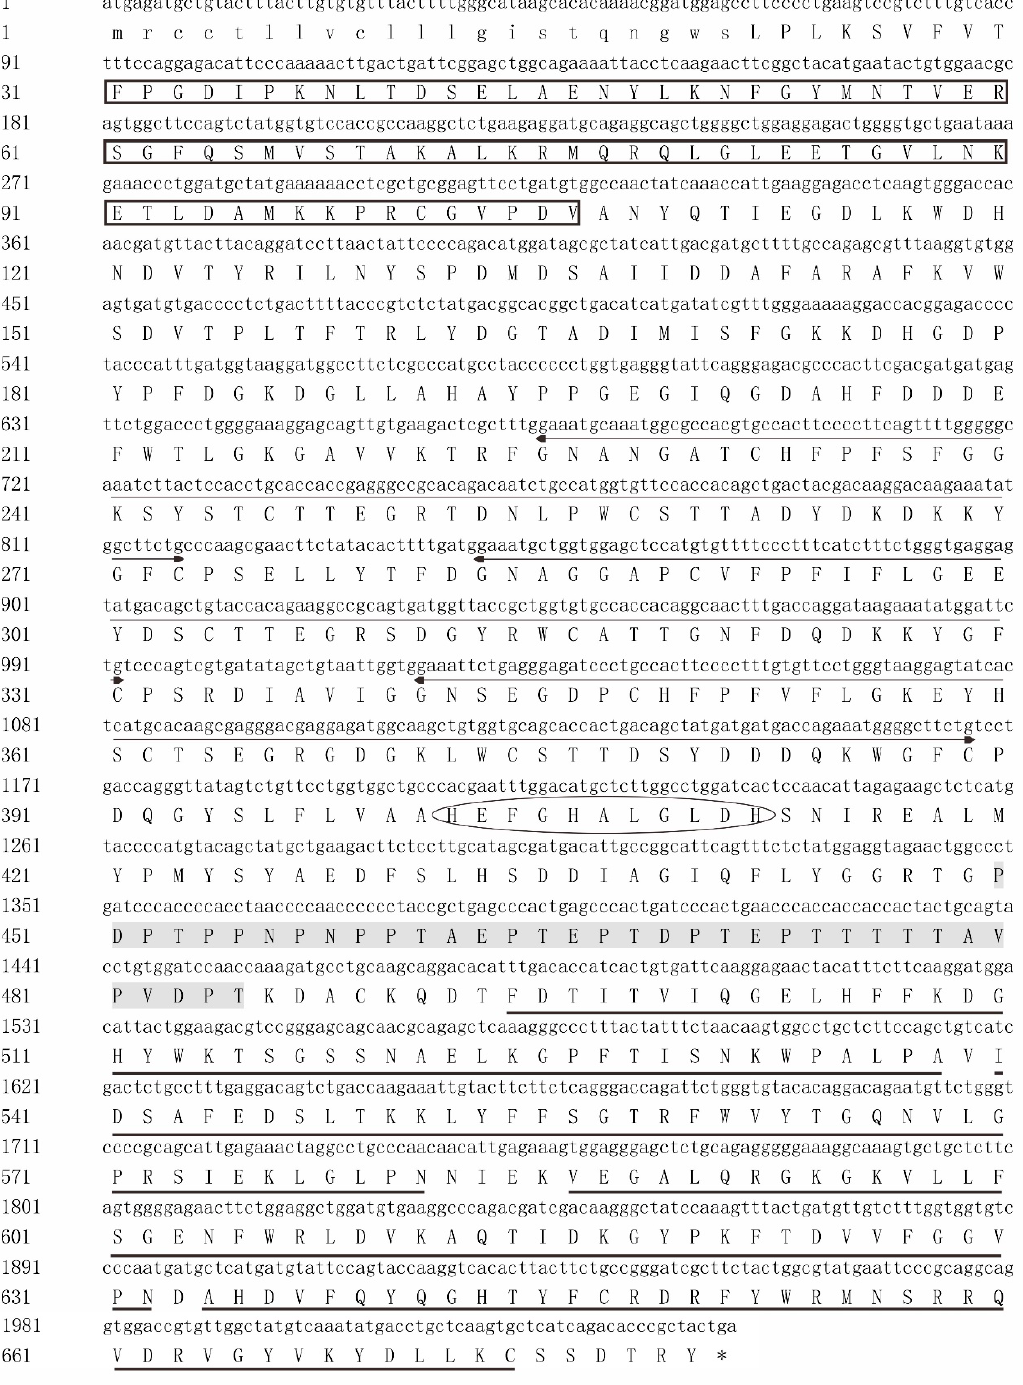
Figure 1. The cDNA sequence and putative amino acids of NtMMP-9 in Nile tilapia.